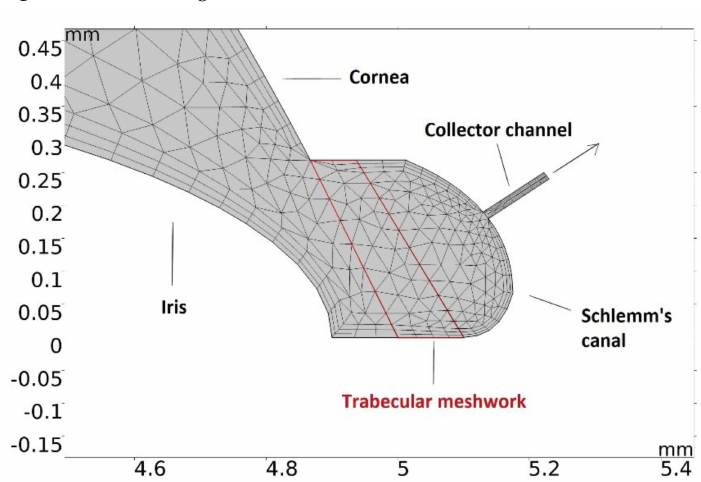
Figure 1. COMSOL generated mesh.